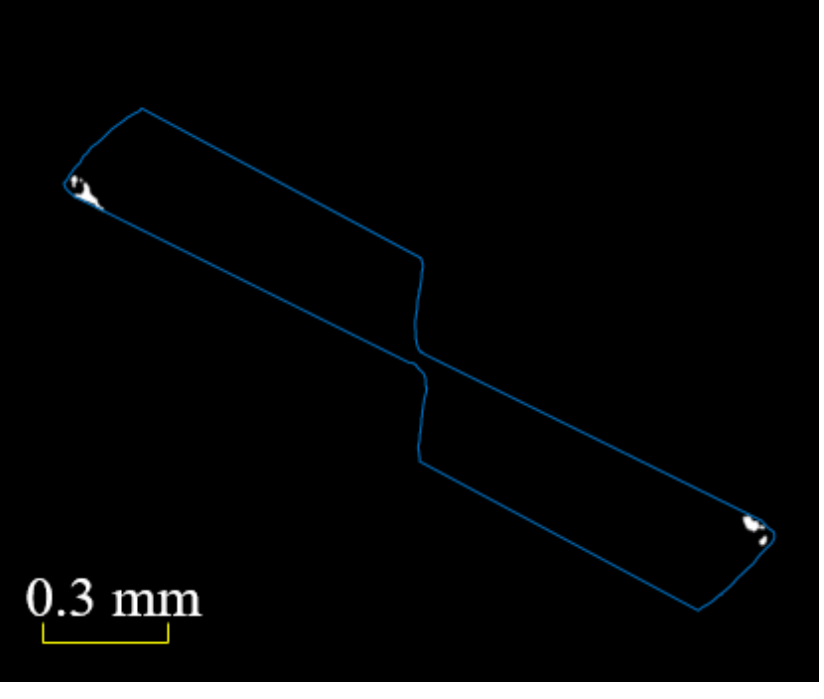
Figure 7. Region-growing algorithm result.